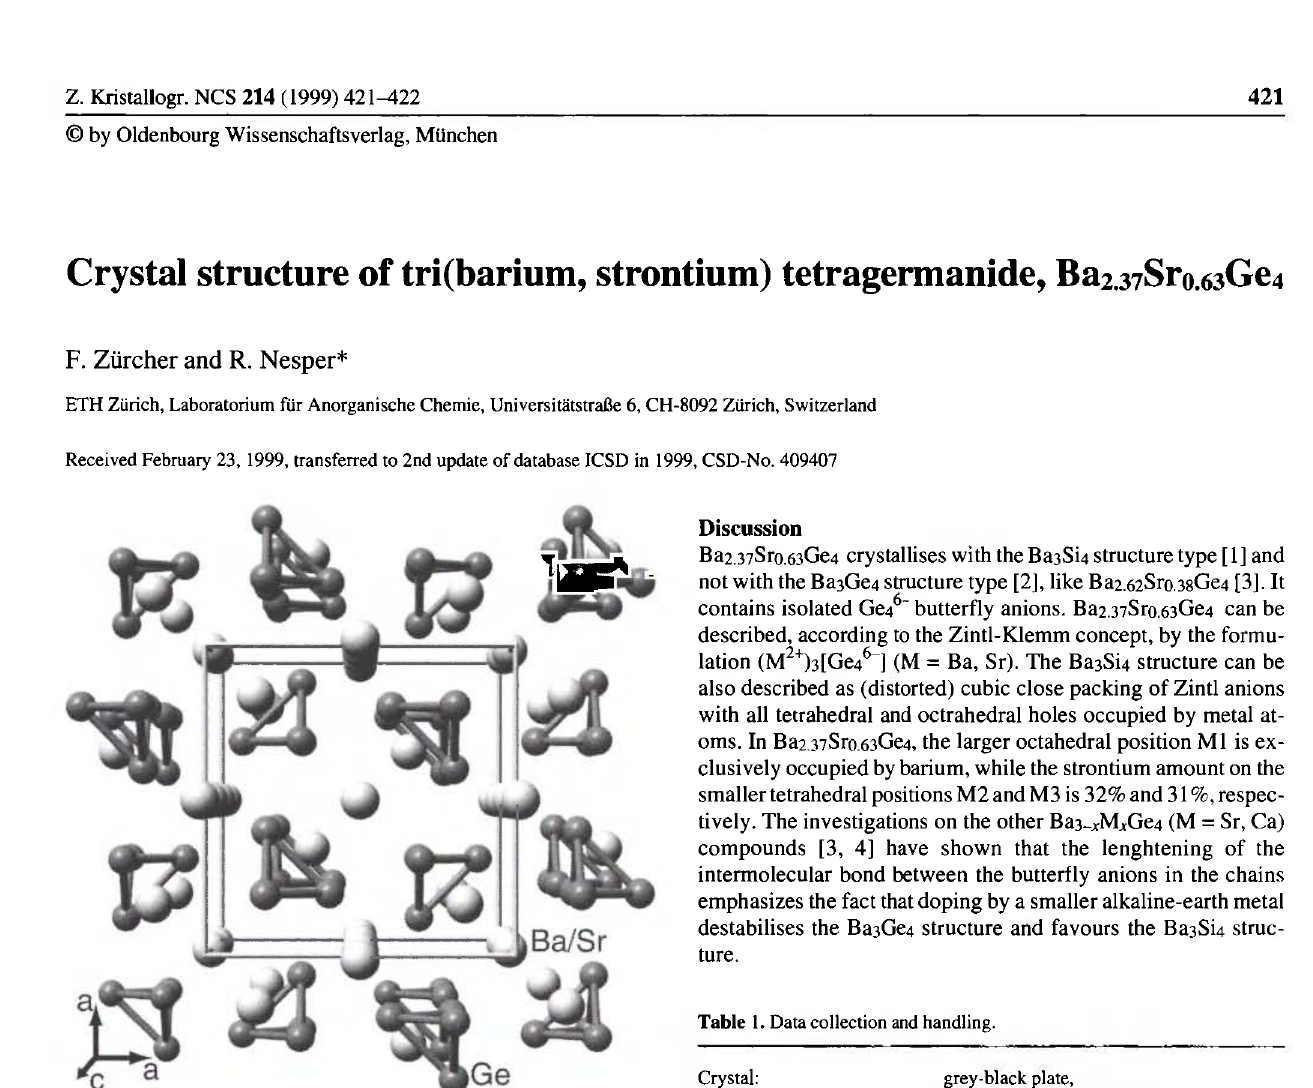
Table 1. Data collection and handling.